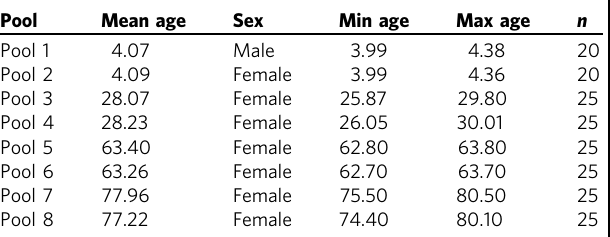
Table 1 Summary information on participants in each pool Total of 190 participants in 8 pools, at 4 time points: 4, 28, 63, & 78